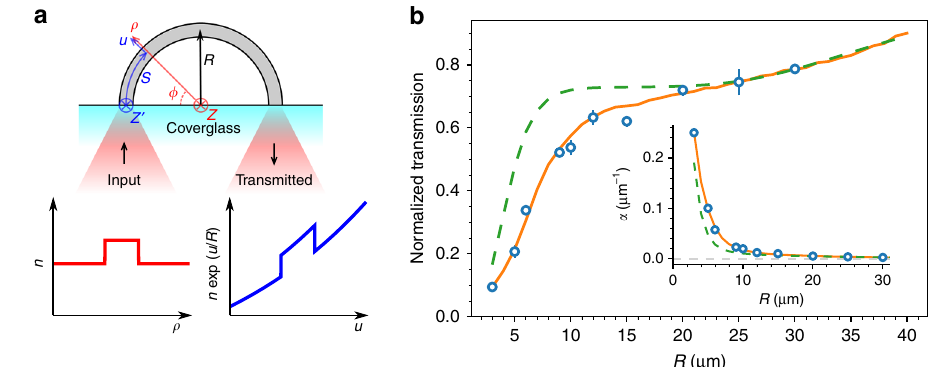
Fig. 2 Bend losses. a An infrared laser beam is coupled into one end of a 180° fi ber arc to measure attenuation of light transmitted to other fi ber end. The red line represents the refractive index ( n ) pro fi le along the radial coordinate ρ . Propagation in curved fi bers can be mapped into a straight fi ber problem with the effective refractive index shown by the blue line. b Transmitted power as a function of the arc curvature radius. Experimental data are shown as circles. Error bars represents the standard deviation between the transmission of 5 arches with same curvature. BPM simulations and analytical prediction are plotted as solid orange and dashed green lines respectively. Inset shows the attenuation coef fi cient per unit length obtained from transmission data in the main panel. Gray dashed line is a guide to the eye representing the axis α =